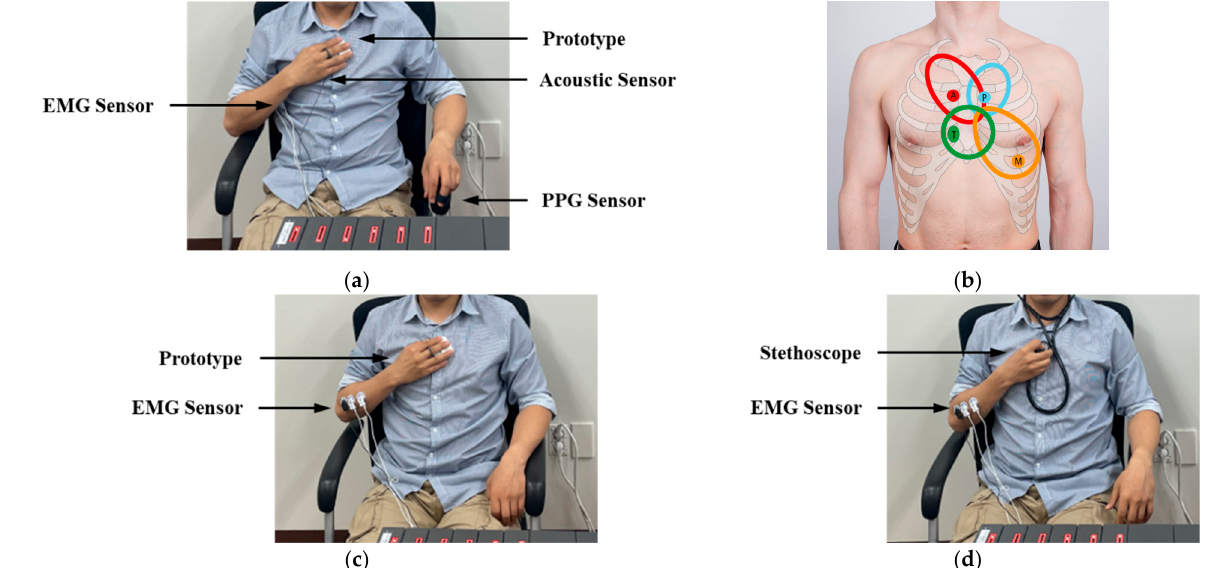
Figure 5. Pictures of the experimental setup for evaluating the performance and usability: ( a ) Photo of a subject in the performance test of physiological signal measurement; ( b ) auscultation positions; ( c ) EMG measurement with the prototype; ( d ) EMG measurement with a standard stethoscope.